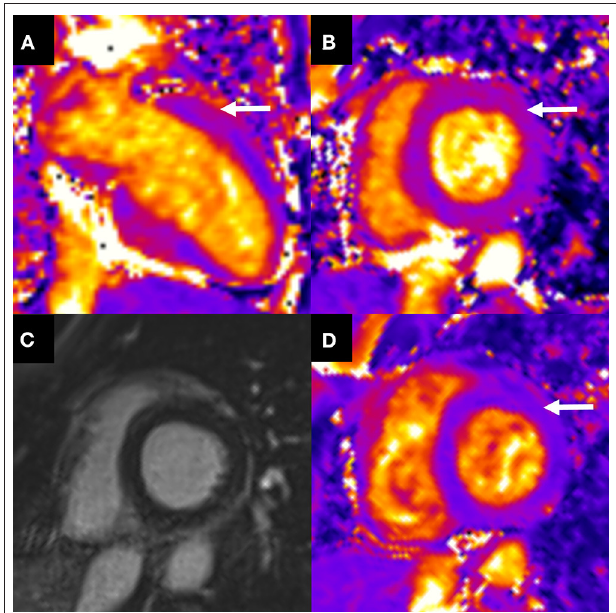
FIGURE 2 | Initial cardiac MRI and follow-up. Cardiac MRI at day 3 after transfer to the nephrology intensive care unit, showed (A,B) an elevation of basal T2 mapping value (60 ± 5ms) related to myocardial edema (arrows) not involving the mid and apical left ventricle without late gadolinium enhancement (C) . (D) One month later, short axis T2 mapping showed regression of the myocardial edema with a normal T2 mapping value (49 ± 1ms)